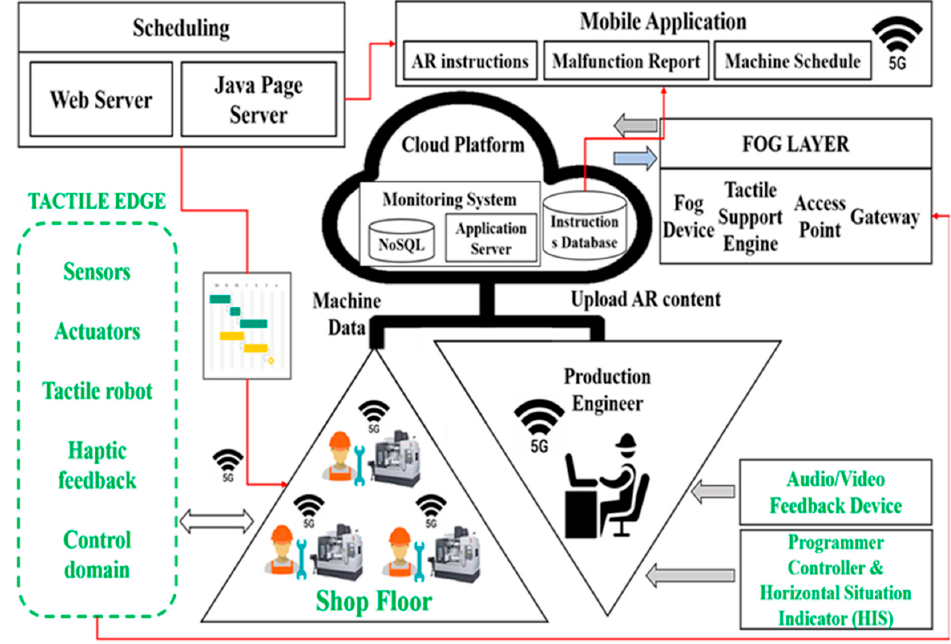
Figure 16. Integrating 5G and TI applications for integrated and adaptive AR maintenance and shop-floor rescheduling (adapted from [67]).